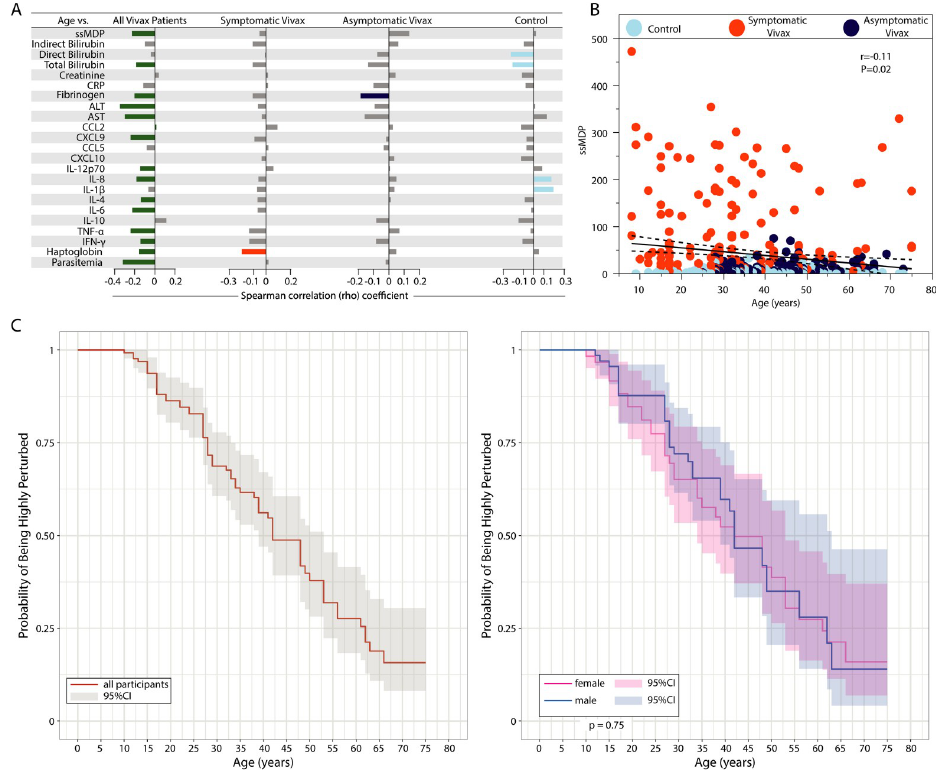
Fig 5. Aging is associated with diminished systemic inflammatory disturbance in vivax malaria. (A) Spearman correlation between age and the global degree of inflammatory perturbation (ssMDP) of the individual MDP values for each parameter. Bars represent the Spearman rank coefficient value (rho). Colored bars (each clinical group is represented by a different color) infer correlations that presented adjusted P-value < 0.05. (B) A scatter plot was employed to show the correlation between age and the ssMDP score values. (C) Probability of being highly perturbed ( > 2 standard deviations from the control group) according to age in all participants (left panel) and in participants grouped based on biological sex. Abbreviations (alphabetic order): ALT: alanine aminotransferase; AST: aspartate aminotransferase; CCL: C-C motif chemokine ligand; CXCL: C-X-C motif chemokine ligand; CRP: C-reactive protein; IFN: interferon; IL: interleukin; TNF: tumor necrosis